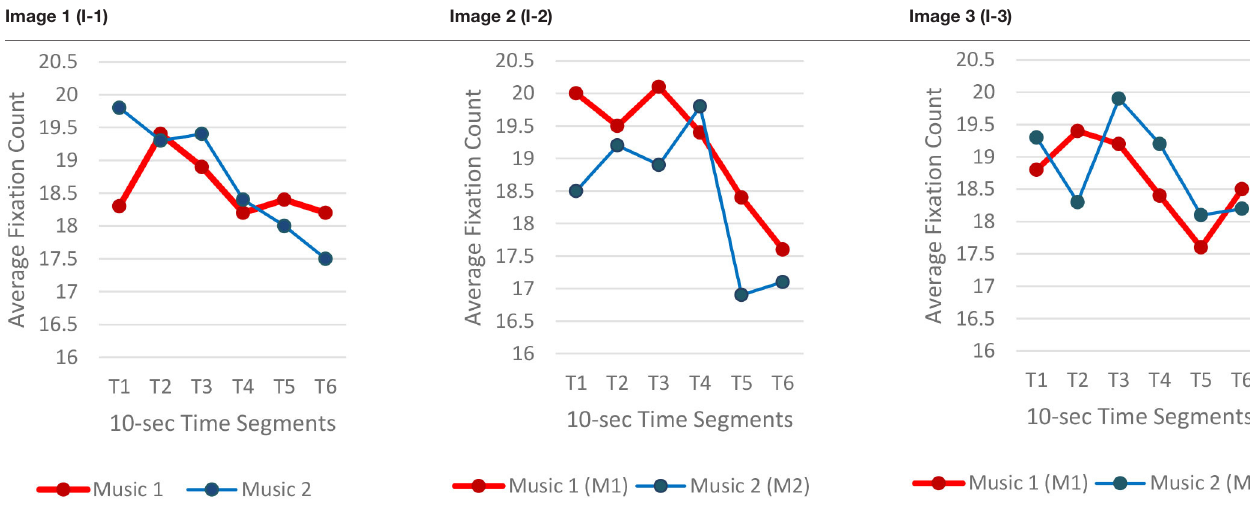
TABLE 2 | Average fixation count by time segment.